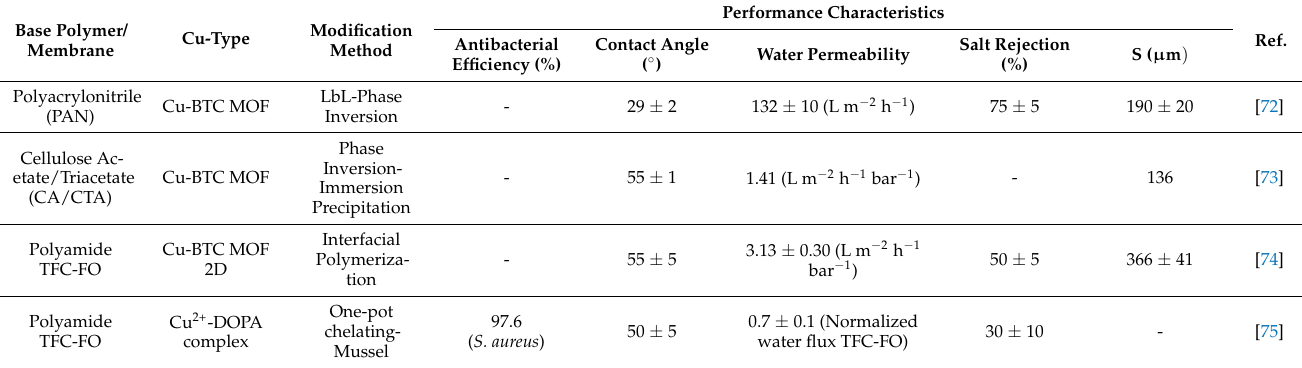
Table 3. Summary of FO membranes modified with different copper-containing